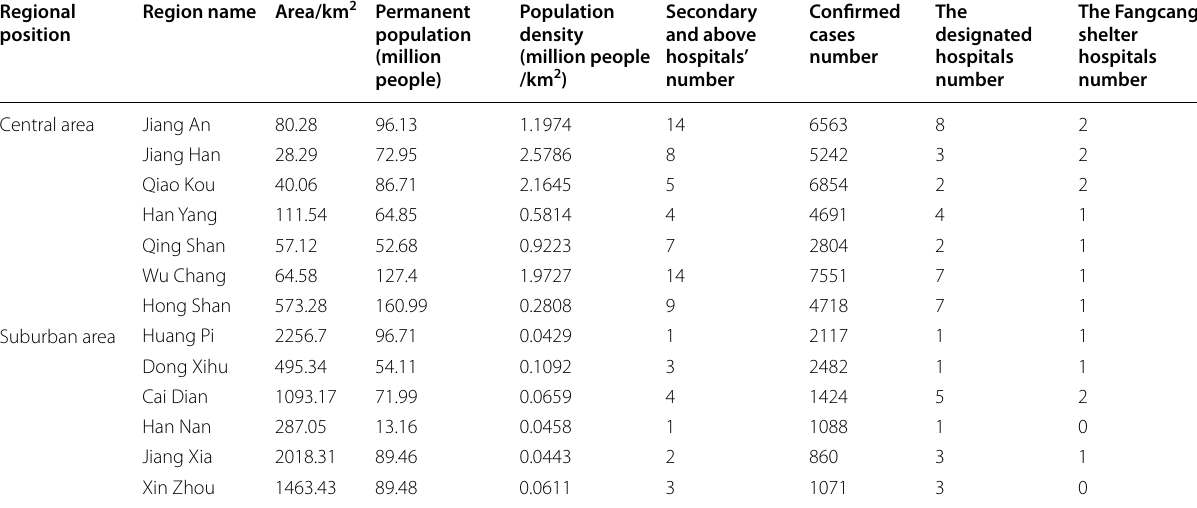
Table 2 Basic information and quantity distribution of emergency medical facilities in Wuhan Regional Region name Area/km 2 Permanent position population